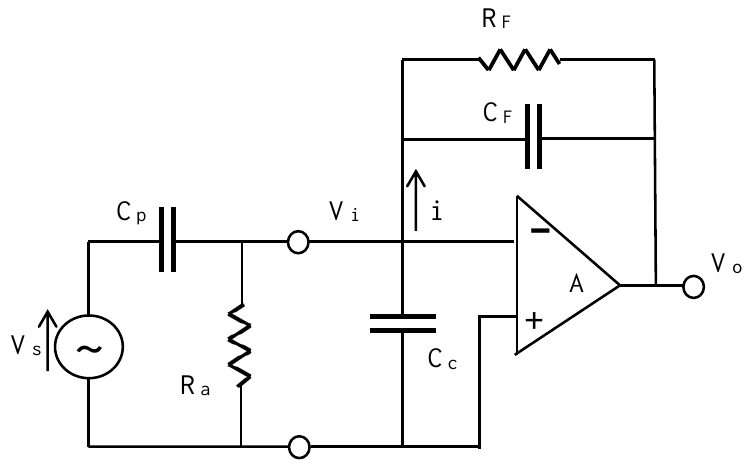
Figure 2 – Electrically equivalent model of a PVDF sensor connected to a charge amplifier. Figure 2. Electrically equivalent model of a PVDF sensor connected to a charge